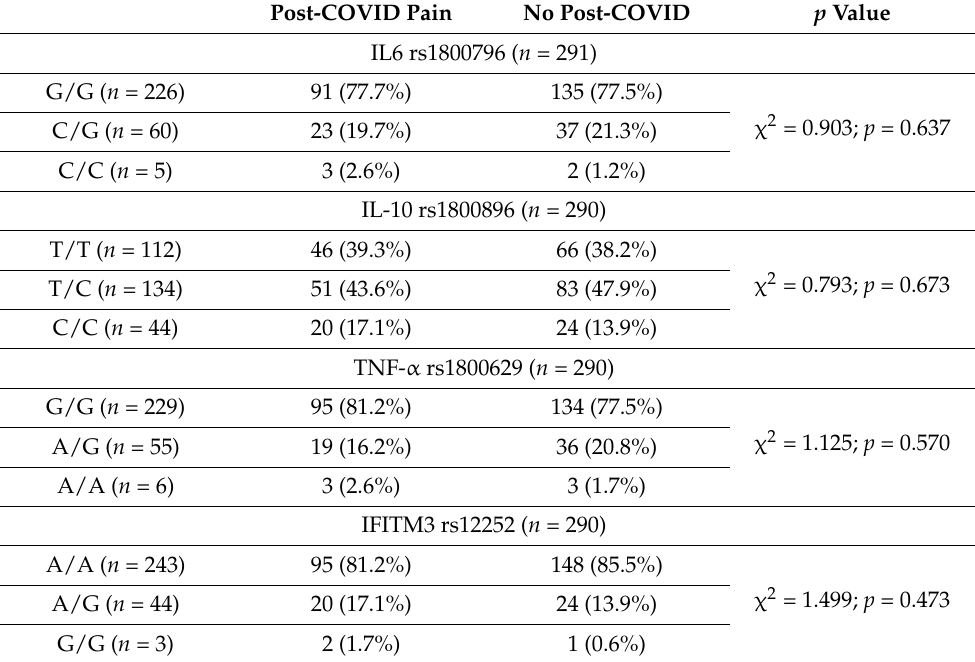
Table 1. Genotype distribution of the inflammatory polymorphisms in COVID-19 survivors with and without post-COVID pain.